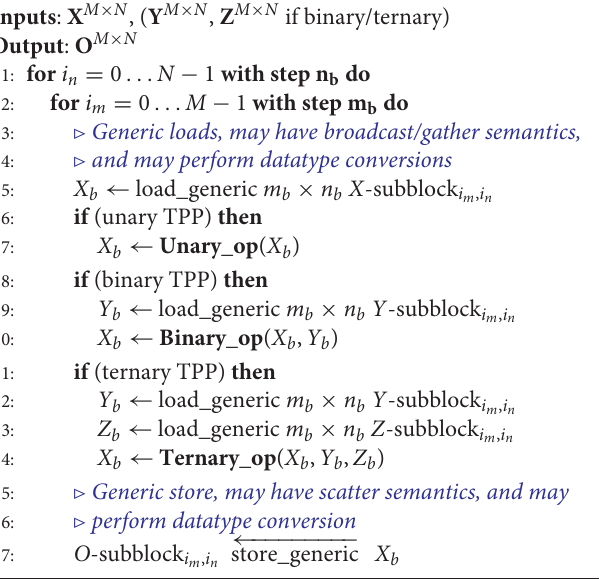
Algorithm 1 | The generic unary/binary/ternary TPP algorithm. Algorithm 2 | The batch-reduce GEMM